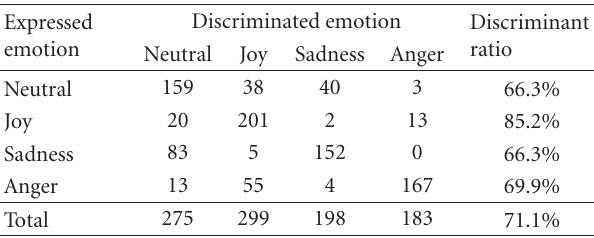
Table 5: Discriminant ratios of emotion (one-handed Finger